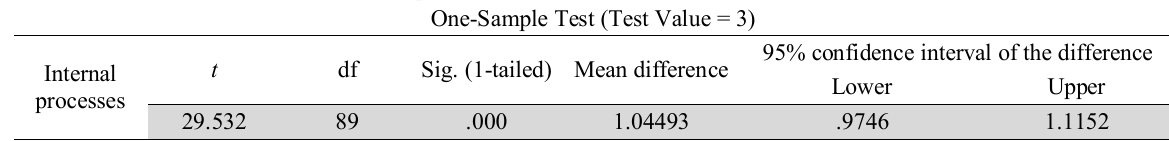
Results of t-test related to the first question